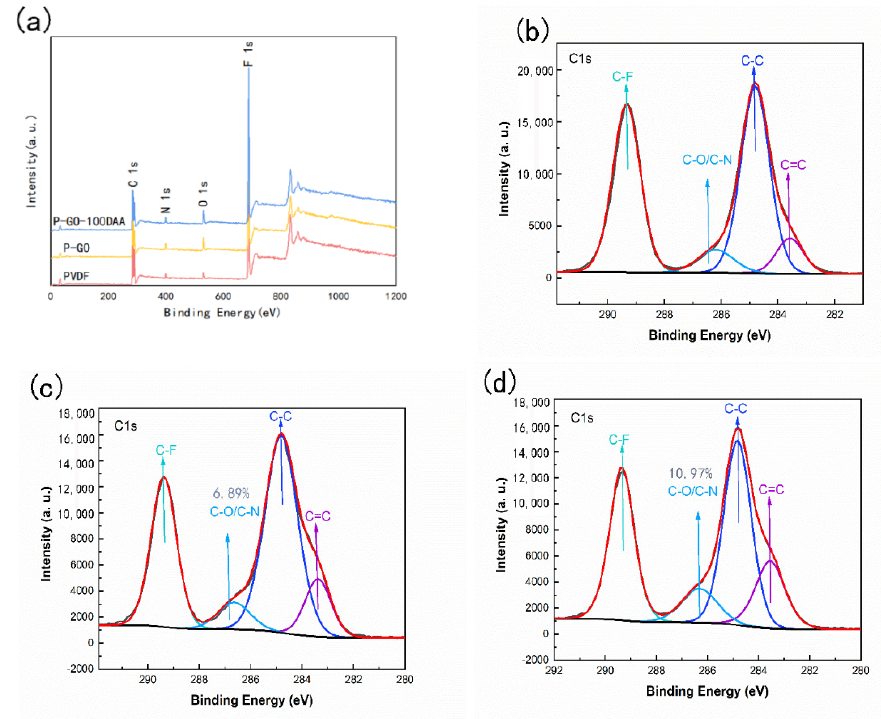
Figure 4. XPS characterization of nanocomposites. ( a ) XPS spectra of PVDF, P-GO, and P-GO-DAA membranes; ( b ) C1s XPS spectra of PVDF; ( c ) C1s XPS spectra of P-GO; ( d ) C1s XPS spectra of P-GO-DAA membranes.